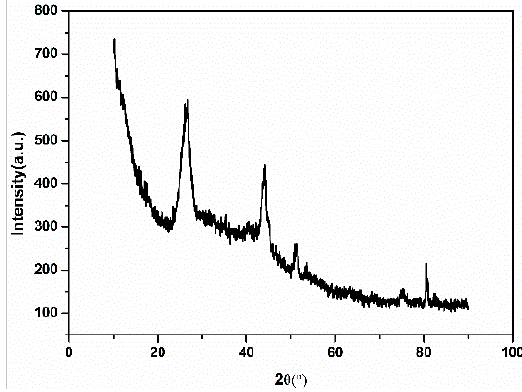
Figure 4. XRD of self-assembled nano-Fe 3 C@RGO aerogel.